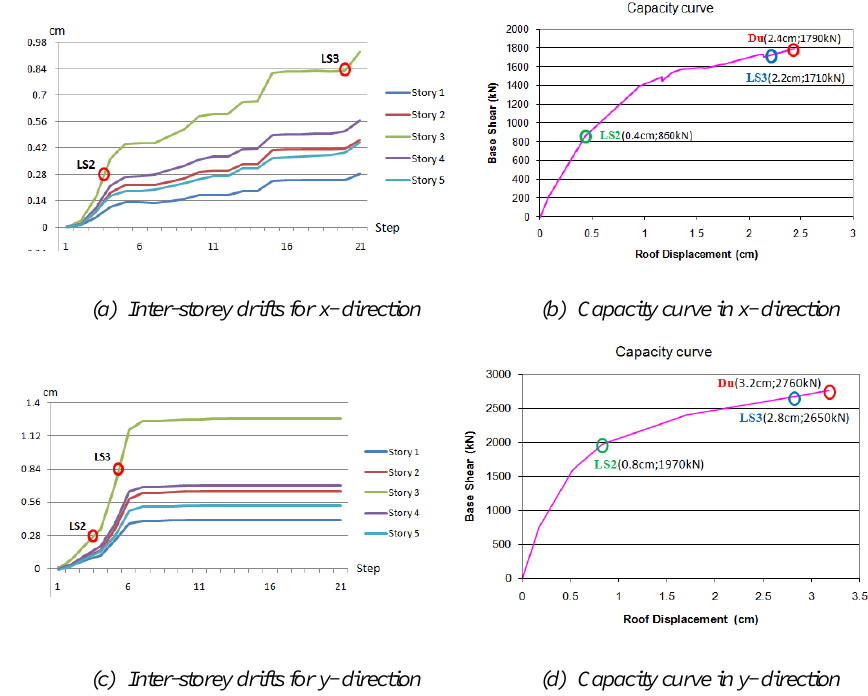
Fig. 9. Inter-storey drift ratios and capacity curve representation of the TD-72/3 obtained by pushover analysis.